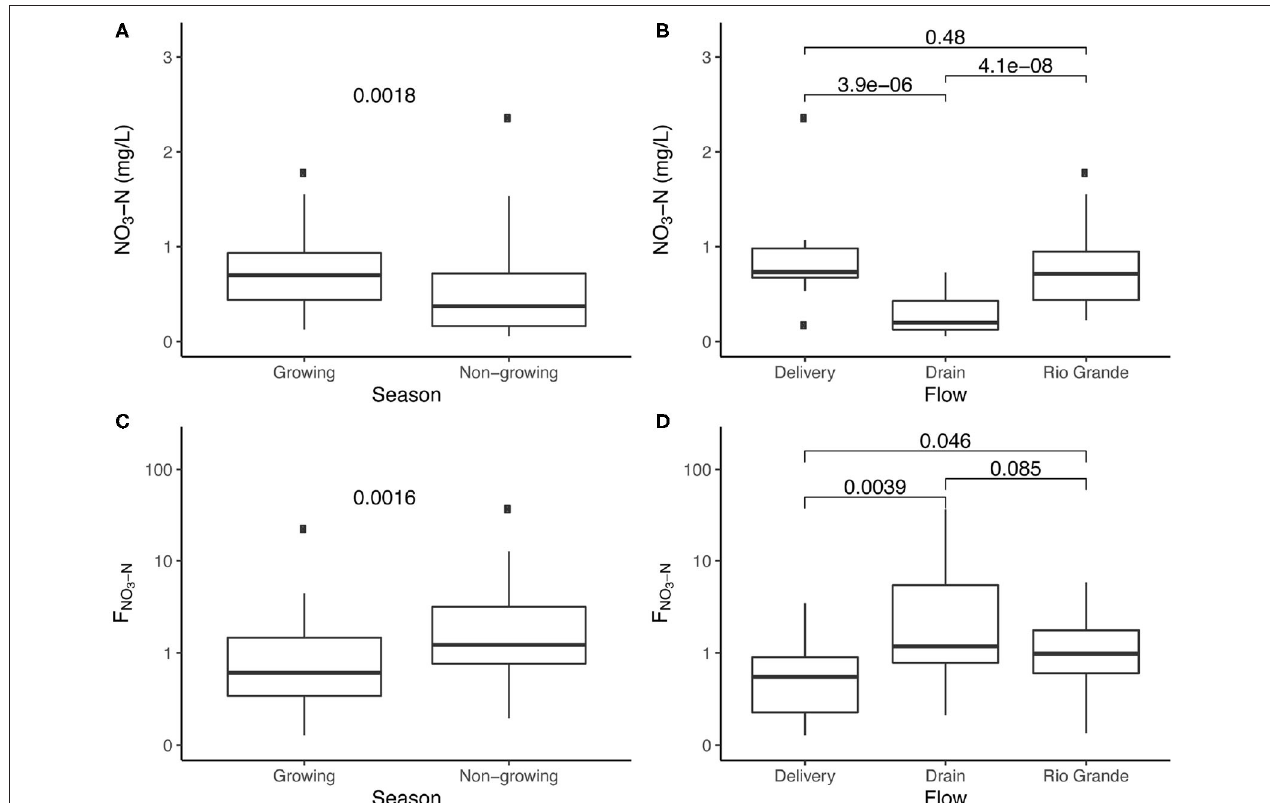
> 1 and F NO < 1 represent source and sink behaviors) divided by season (A,C) and flowpath (B,D) . 3 3